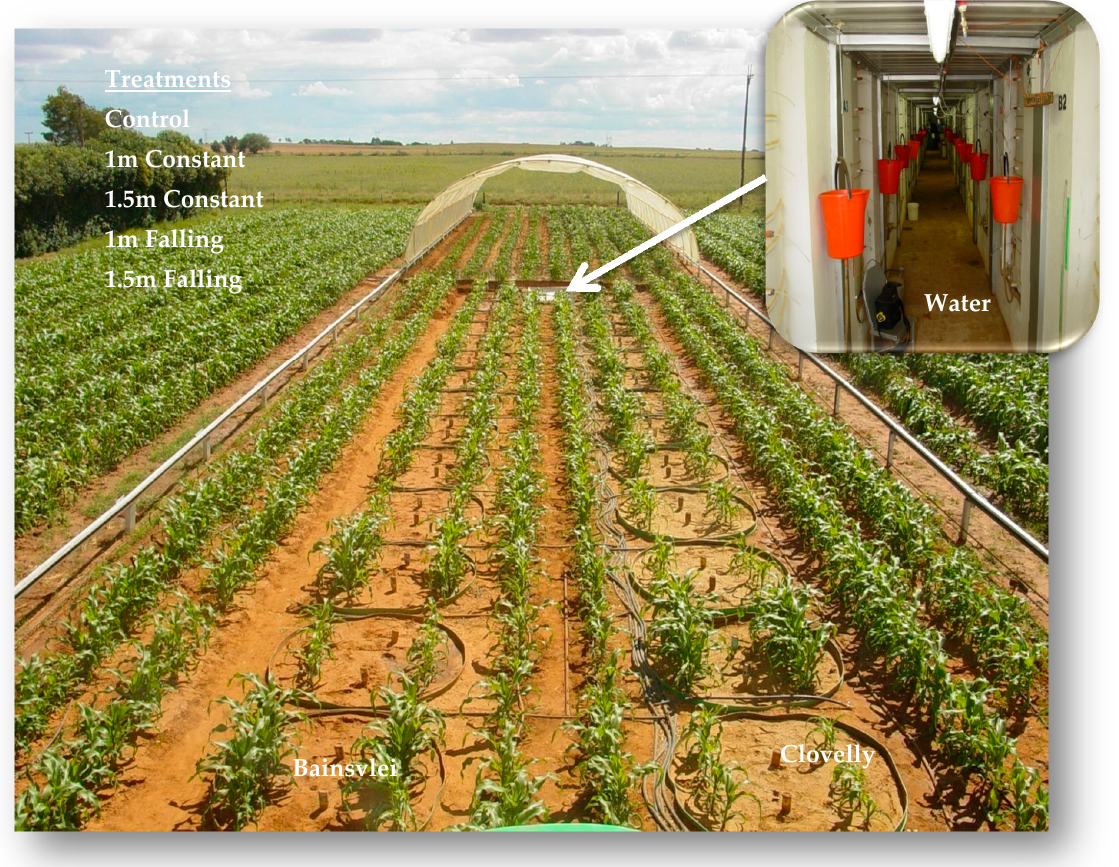
Figure 3. Lysimeter trial for evaluation of different groundwater levels.